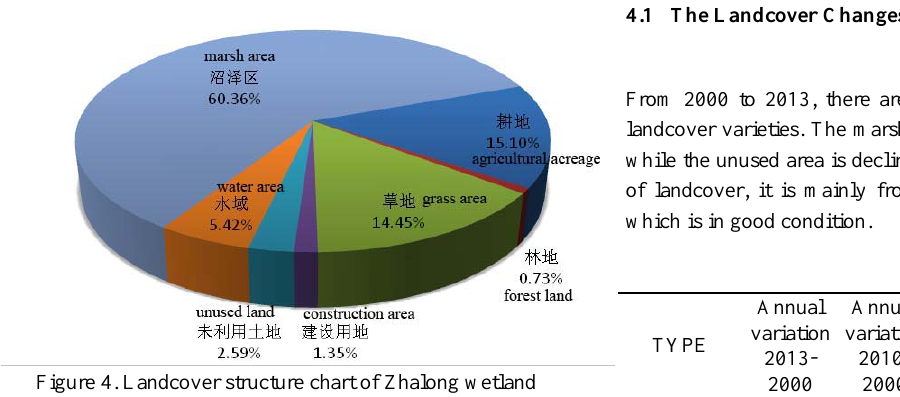
Figure 4. Landcover structure chart of Zhalong wetland reserve in 2013 Unit: square metre